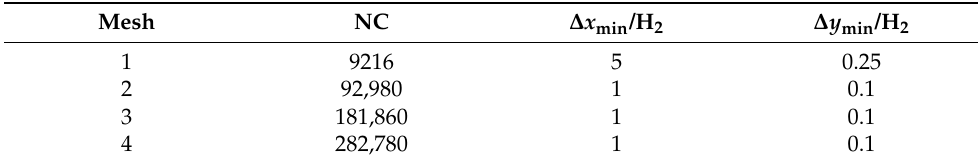
Figure 3. Average velocity at the exit of the blade channel for four different meshes in model 1. Table 1. Characteristics of the computational meshes used in SDC. Table 1. Characteristics of the computational meshes used in SDC.